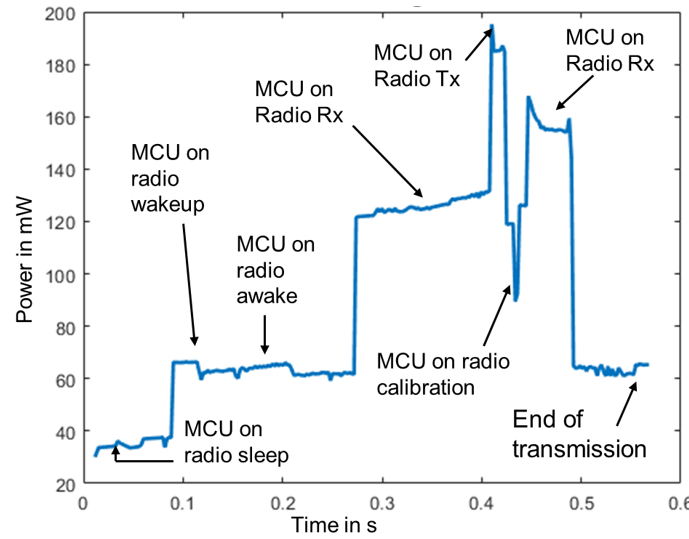
Figure 12. Bluetooth power consumption.